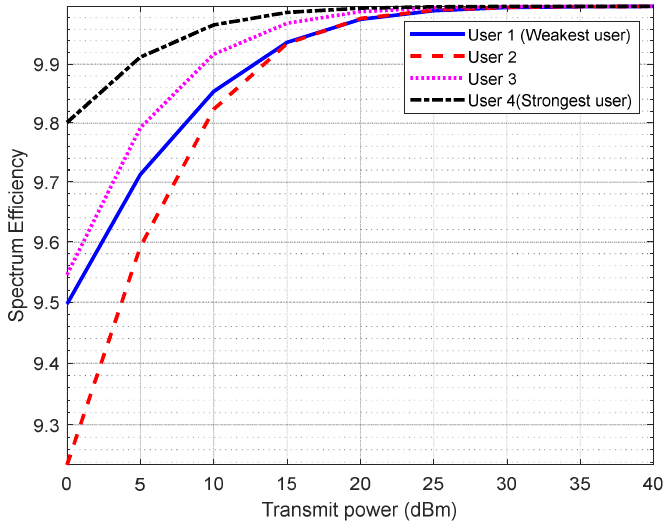
Figure 10. SE against transmitting power for four users with varying distances, with power coeffi- cients with the 64 × 64 MIMO and BW 200 MHz for DL NOMA.